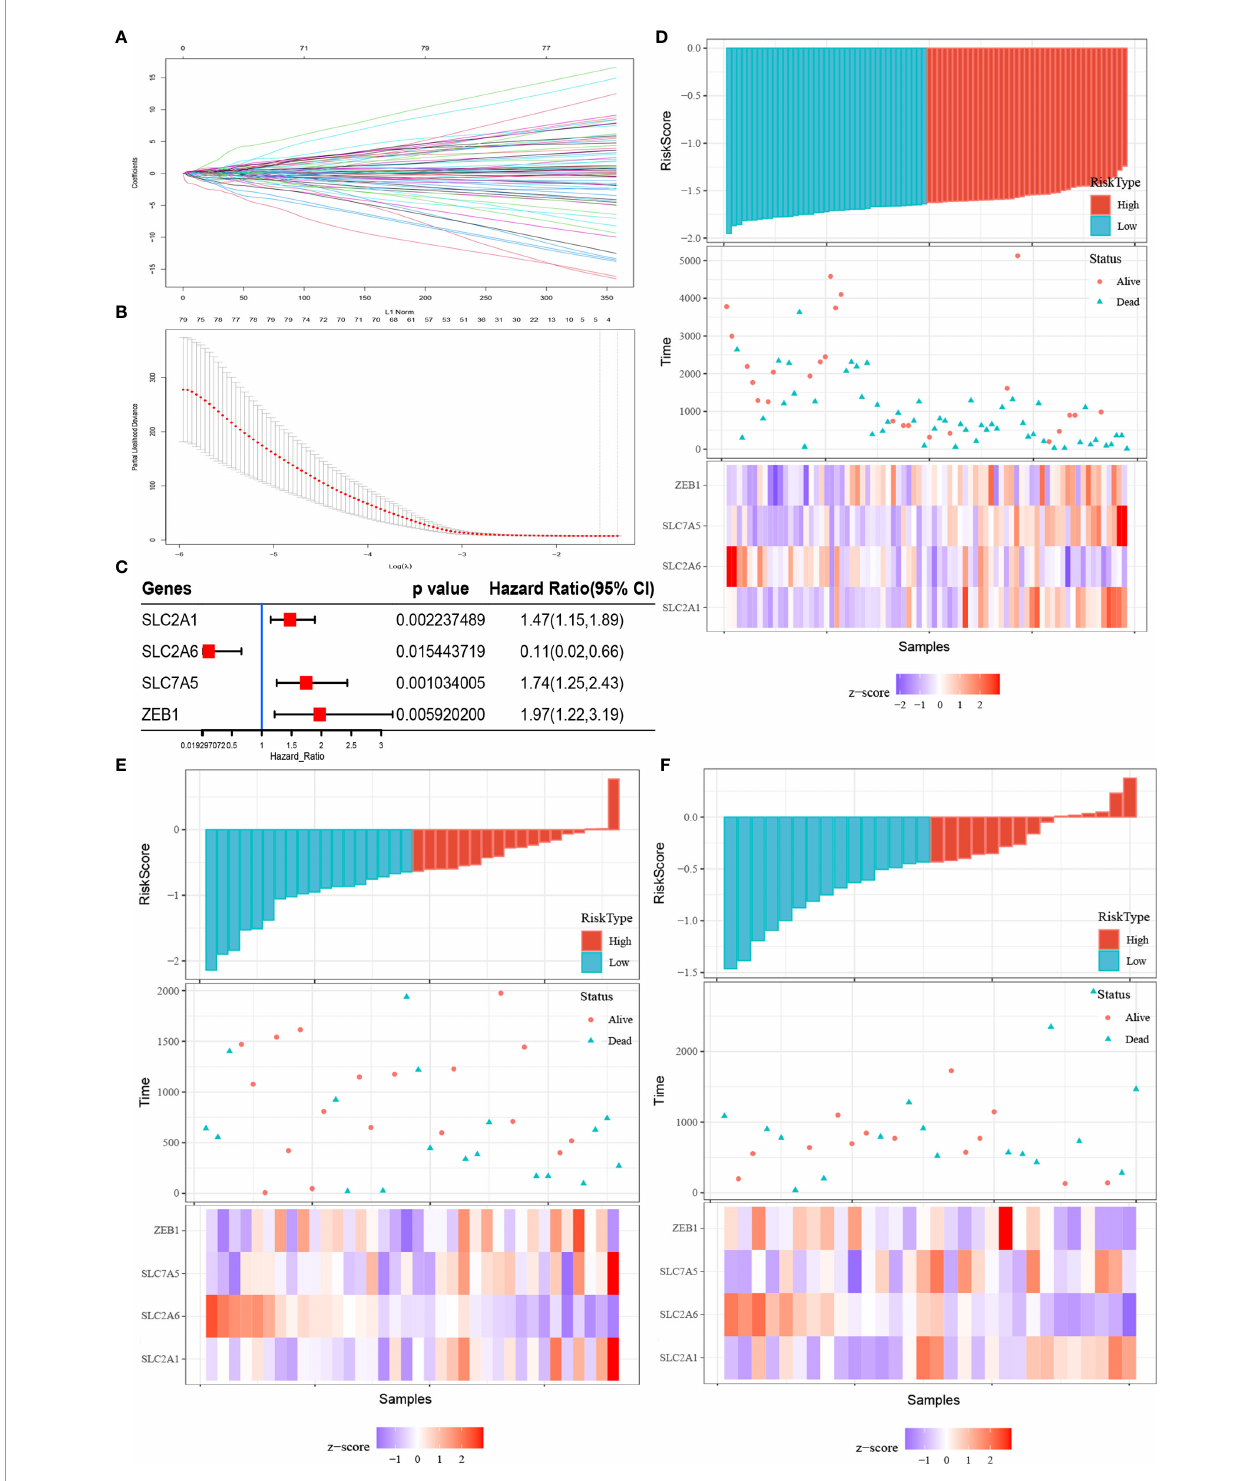
FIGURE 3 | Fer-score model construction and visualization. (A, B) are the LASSO coef fi cient pro fi les and LASSO deviance pro fi les, respectively. (C) Forest plots of the Cox analysis of four genes screened by LASSO Cox. (D – F) Risk score (top panel), survival status (middle panel), and single gene expression level (bottom panel) of the E-MTAB-6389, TCGA-CHOL, and GSE107943 data